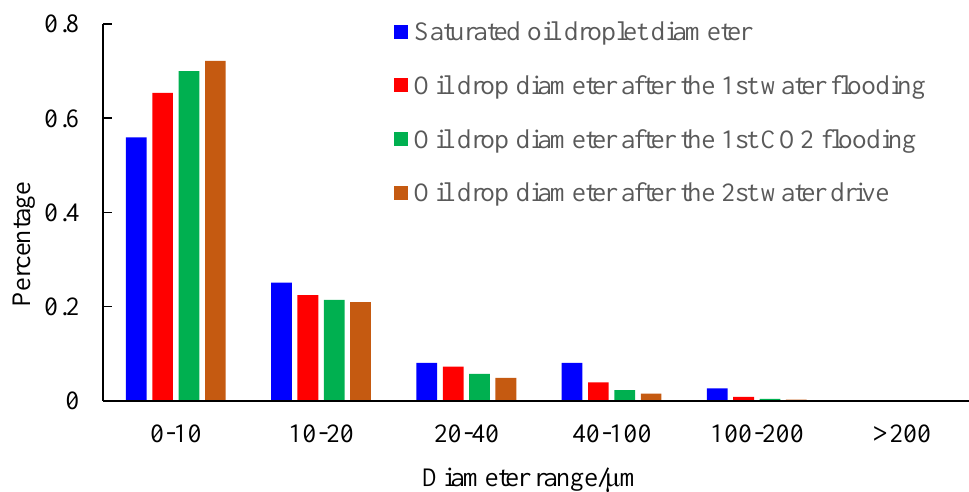
Figure 26. Distribution of the residual oil drop diameter of the Y56 – 19 core.